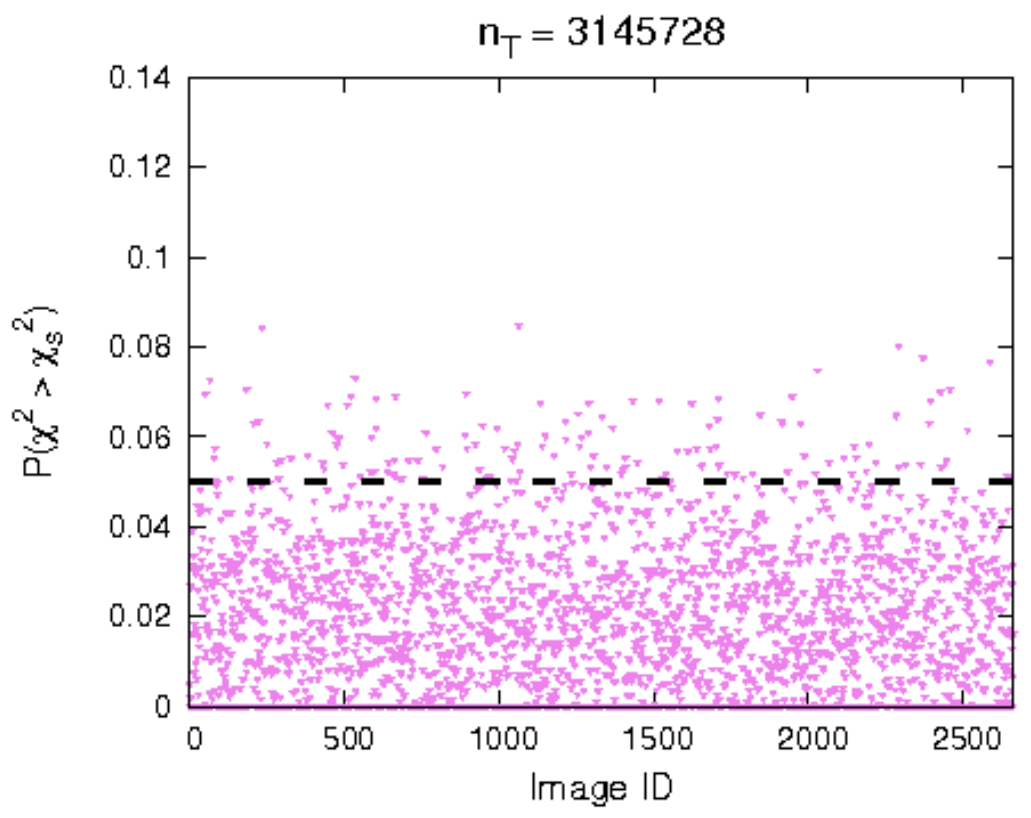
Figure 22. Results of χ 2 test, 3,145,728 surface triangles.